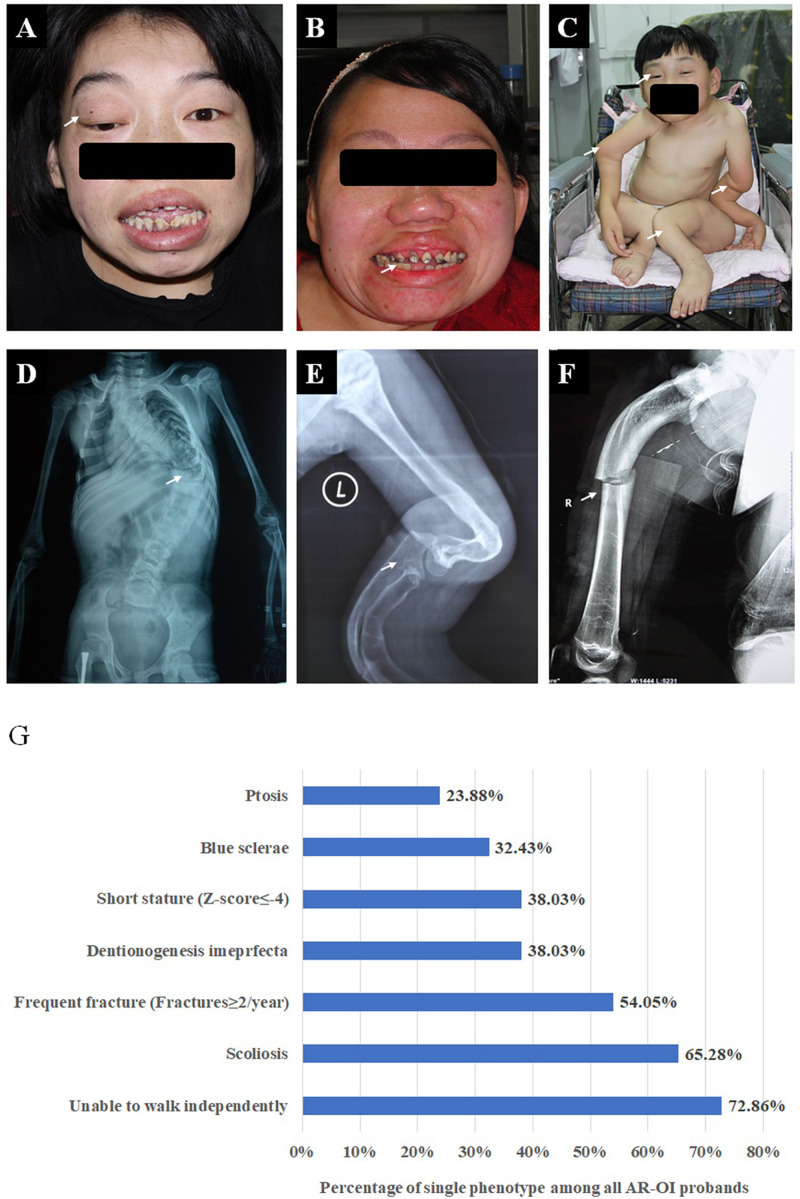
Phenotypic characteristics of AR-OI patients (A–F). AR-OI patients had severe clinical manifestations including ptosis (A), dentinogenesis imperfecta (B), severe limb deformity and disability to walk independently (C), scoliosis (D), skeleton deformity (E), and frequent fractures (F). (G) Percentage of the presence of each clinical manifestation in AR-OI probands.